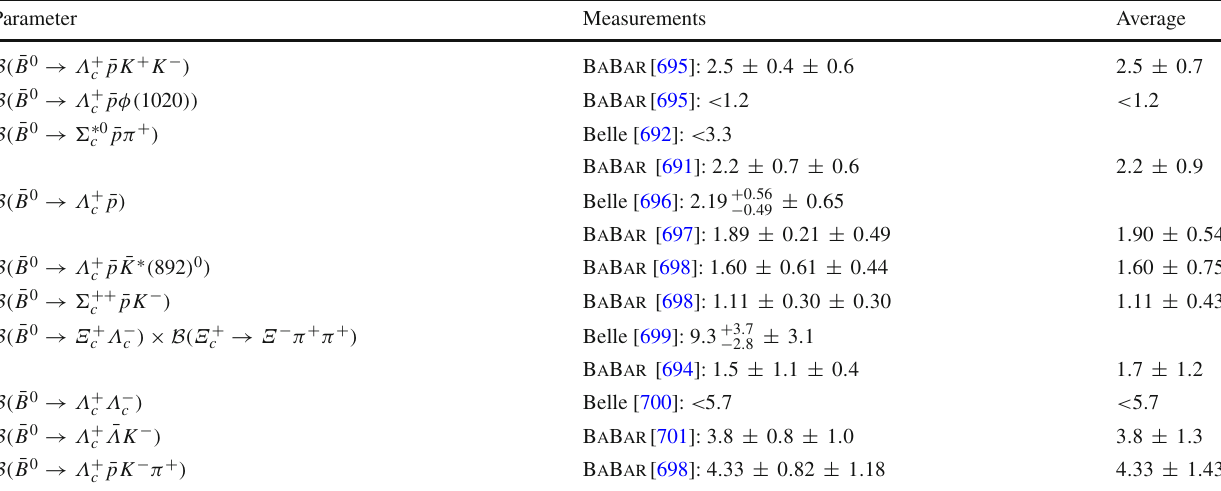
Table 126 Absolute decay rates to charm baryons II [ 10 − 5 ]